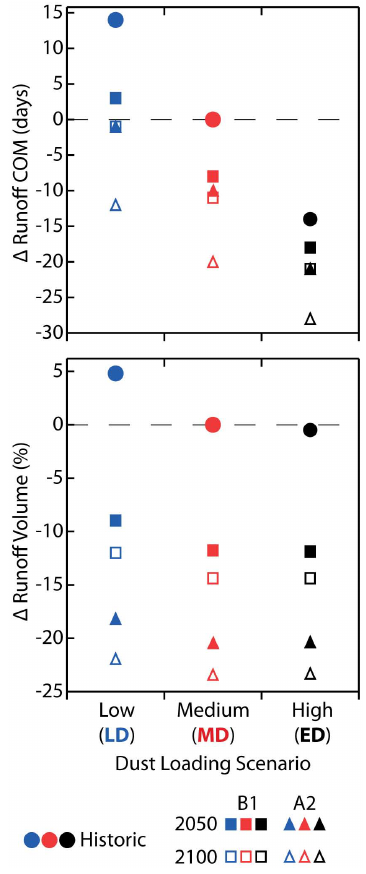
Fig. 11. Sensitivity of center-of-mass timing (a) and annual runoff volume (b) under various climate scenarios for low (LD), medium (MD), and high (ED) dust emission